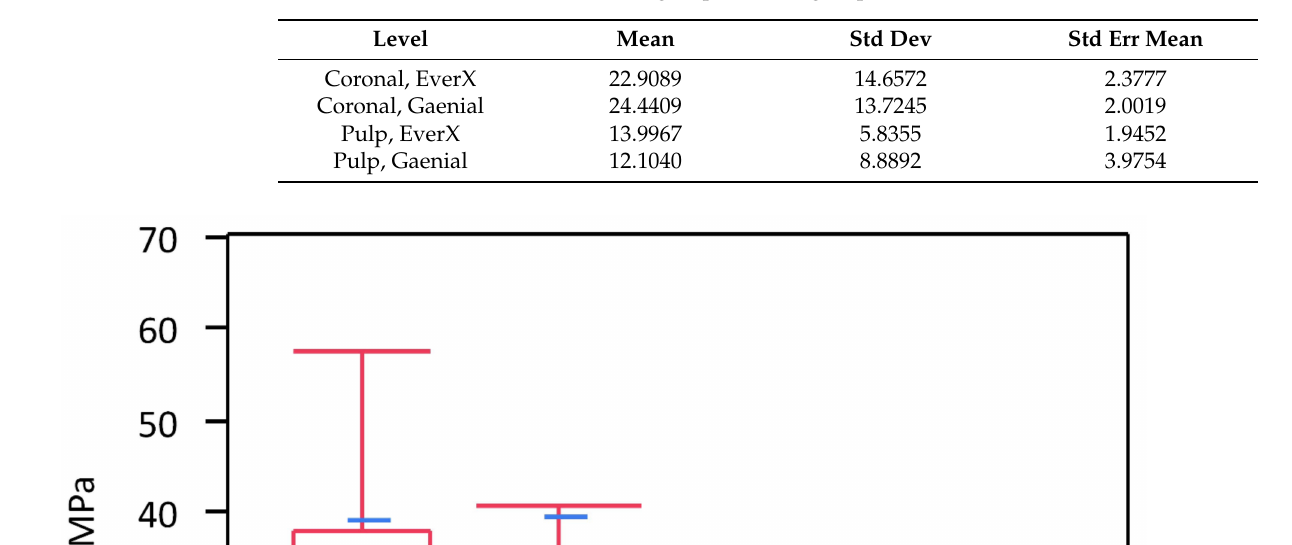
Table 3. Mean maximum load to failure of the microtensile bond strength test (MPa), standard devia- tion, and standard error for the tested groups and subgroups.